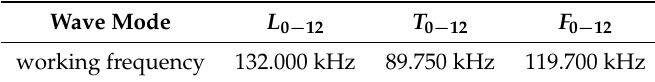
Table 1. Working frequency for axial length at 0.02 m.